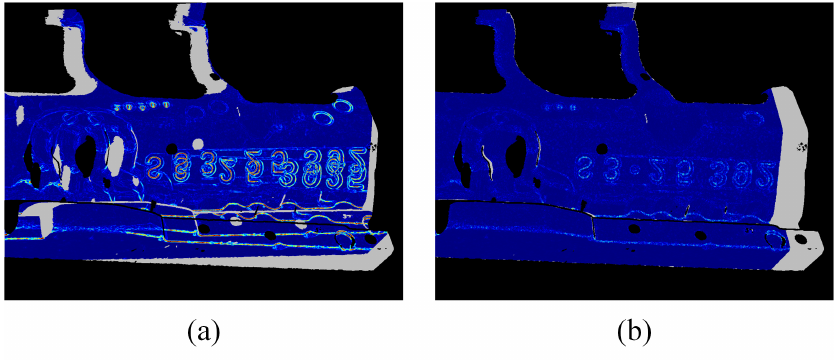
Figure 4. Curvature difference map ( a ) Before registration, ( b ) After